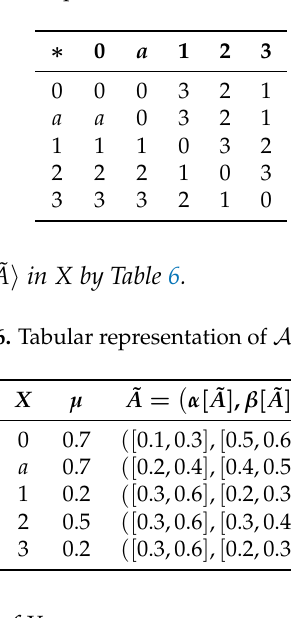
Table 5. Tabular representation of the binary operation ∗ .